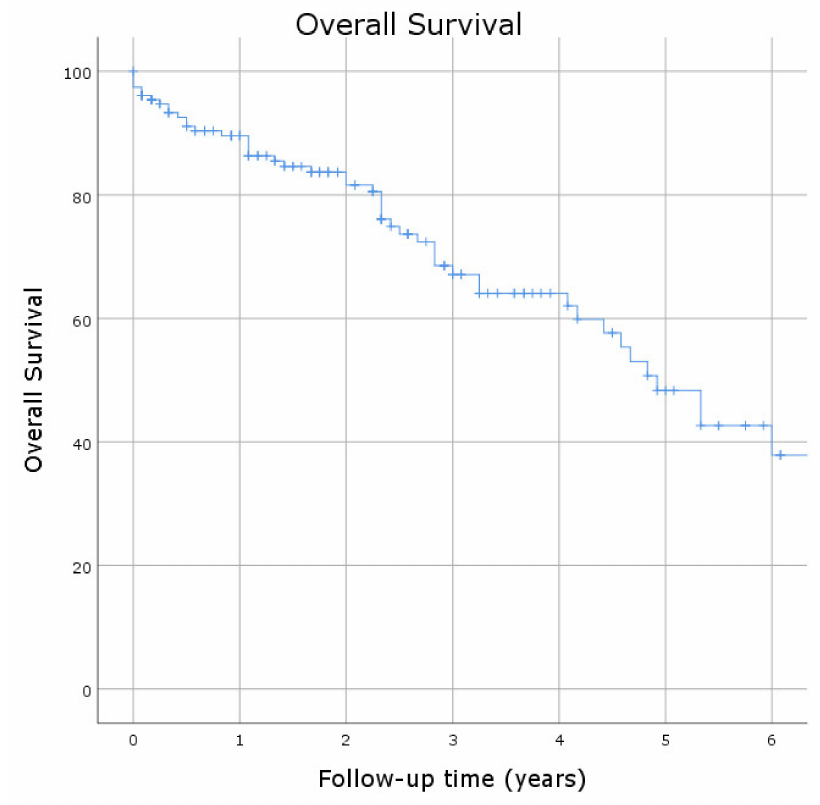
Figure 4. Kaplan–Meier curve estimated for the overall survival at mid-term